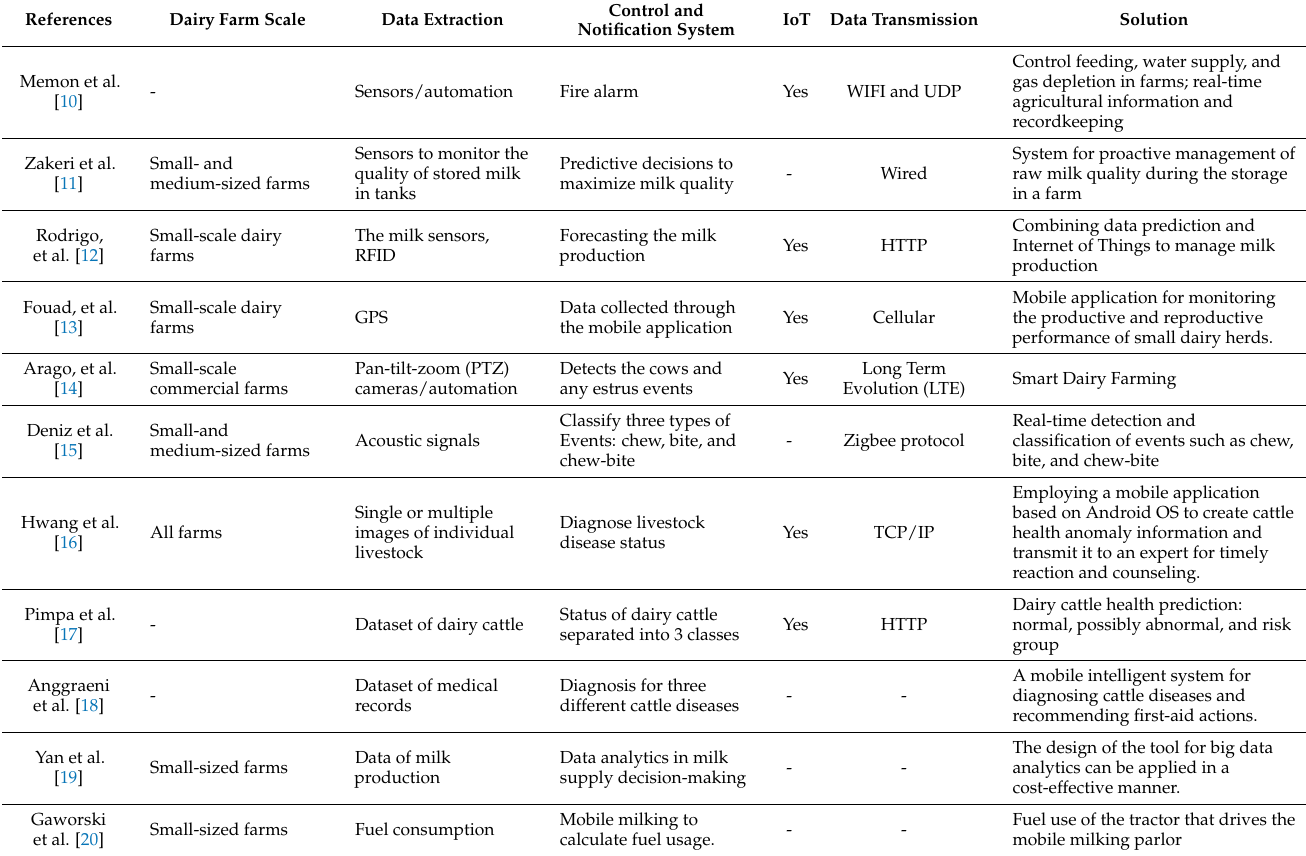
Table 1. Related studies in this